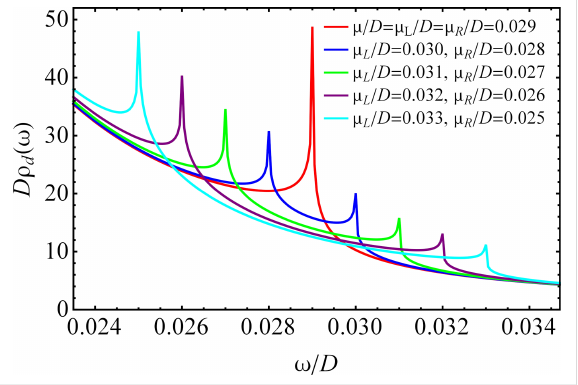
Figure 2: The DOS in the QD for different values of the chemical potentials at temperature T / D = 5 × 10 − 6 with U / D → ∞ and in absence of a magnetic field. Additional parameters: η = 0.02 and ε d / D = − 0.011.